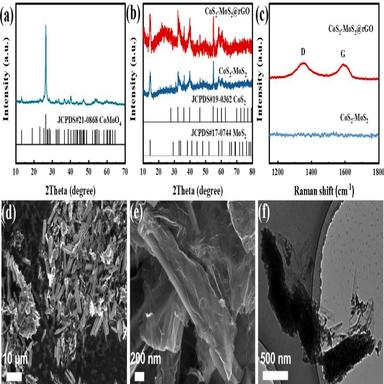
XRD patterns of the (a) CoMoO4 precursor and (b) CoS2-MoS2 intermediate and CoS2-MoS2@rGO composite, Raman spectra of (c) CoS2-MoS2 intermediate and CoS2-MoS2@rGO composite, SEM images of (d) and (e) of CoS2-MoS2@rGO composite, TEM image of (f) of CoS2-MoS2@rGO composite.